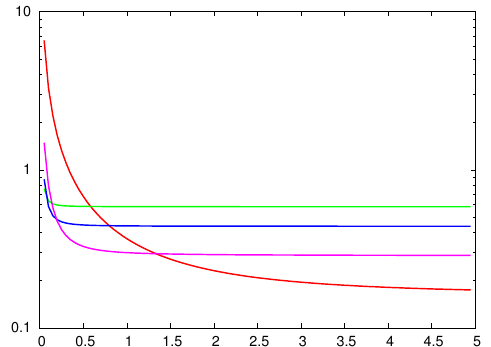
Fig. 16. Evolution of the ratio output noise/input noise depending on the value of input noise for slightly correlated noise ( β = 1). Red curve: fusion; green curve: median filter with 3 × 3 neighbourhoods; blue curve: median filter with 5 × 5 neighbourhoods; purple curve: median filter with 11 × 11 neighbourhoods. For large input noises fusion performs better than the others; the crossover points occur for input noise levels of about 0.6, 0.8, and 1.3, respectively.